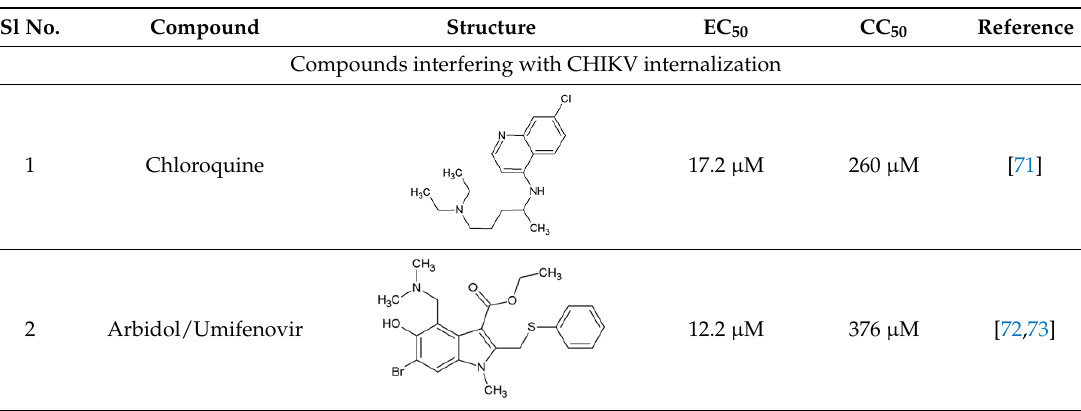
Table 2. Compounds with anti-CHIKV action.